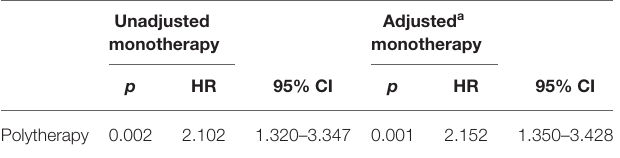
TABLE 2 | DDD, mean PDD, and percentage of DDD in the two groups. Antiseizure DDD (mg) Monotherapy medication